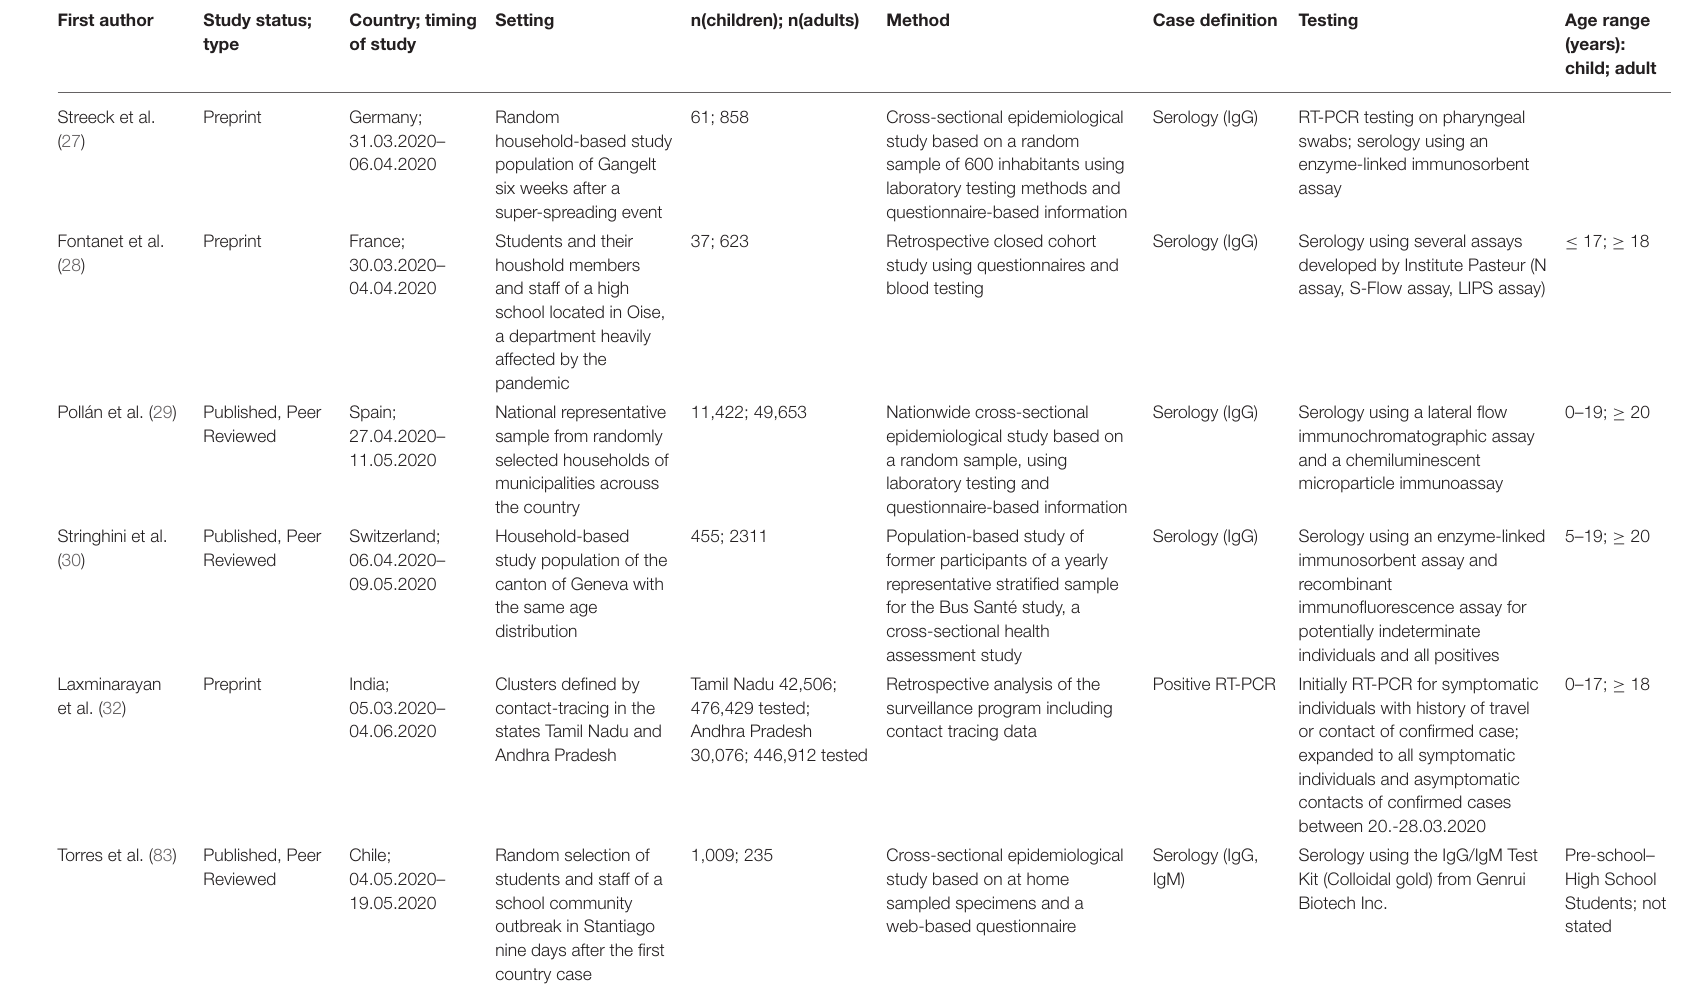
TABLE 3 | Characteristics of study results from PCR-prevalence and serology